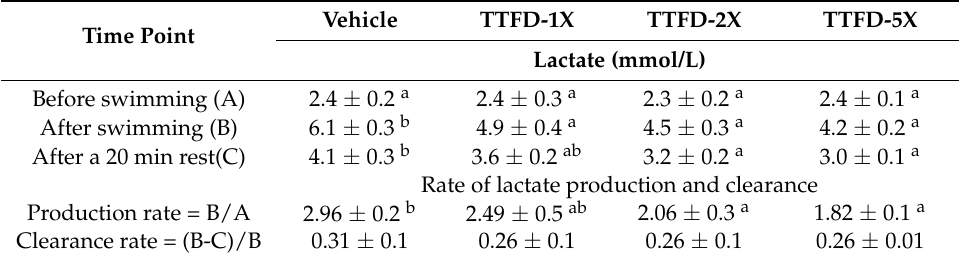
Table 1. The effects of TTFD on lactate metabolite profiles during acute exercise challenge.